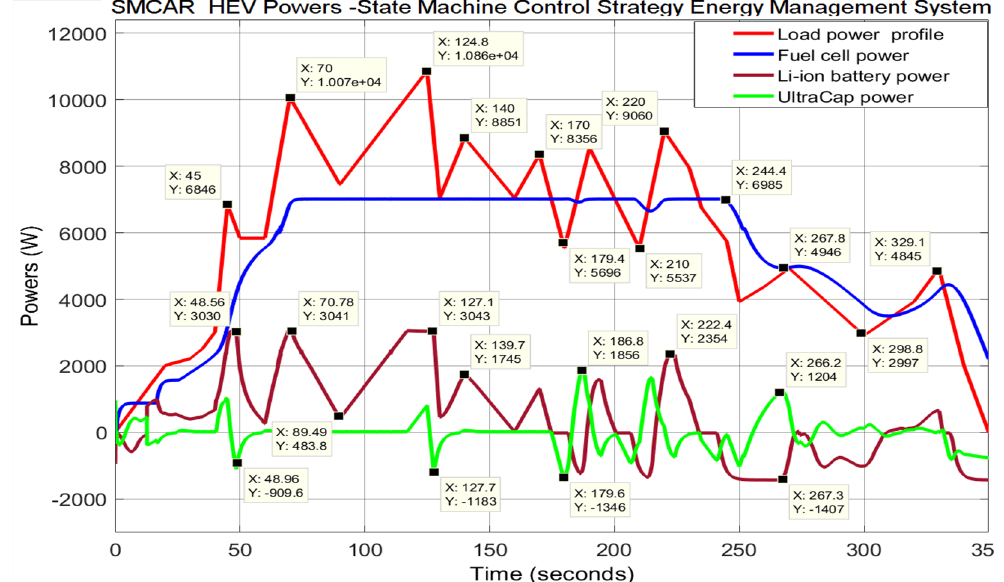
Figure 24. SMCAR HEV power–EMS state machine control strategy setup.